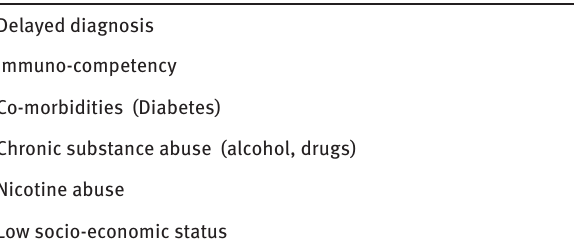
Table 2: Risk factors